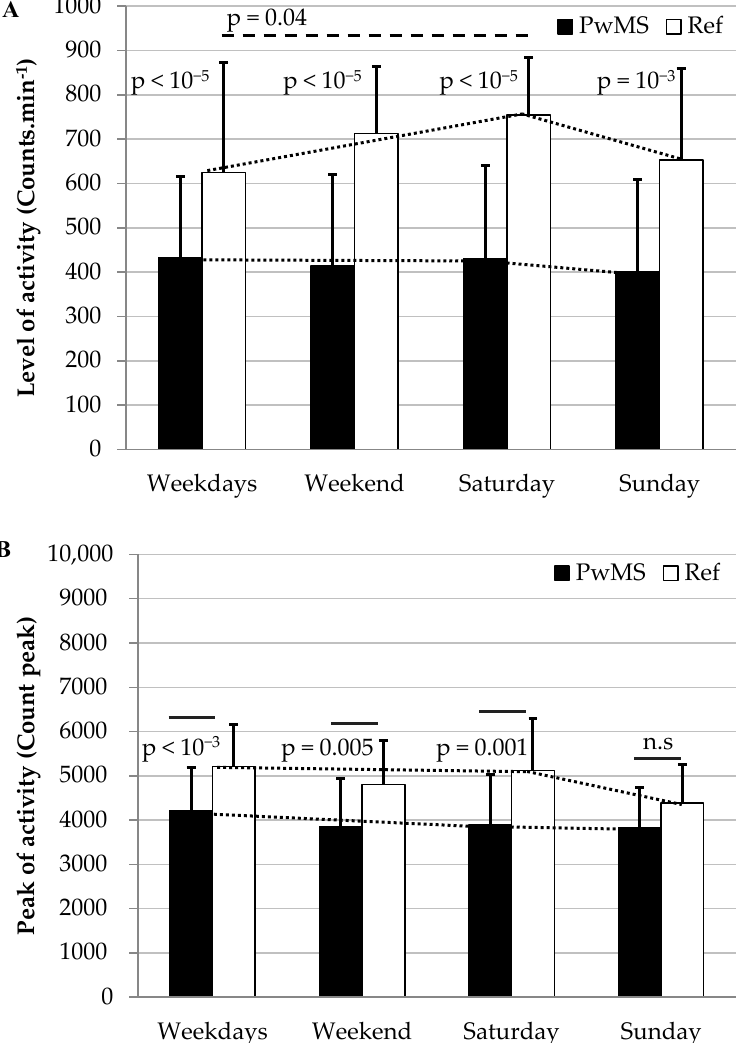
Figure 1. The level of physical activity (mean counts · min − 1 ( A ) and peak ( B )) on the weekdays, weekend, Saturday and Sunday and comparisons between MS and Reference groups. PwMS had a monotone level of activity throughout the week, whereas the Ref group had an improvement of activity on Saturday compared with those on weekdays. Abbreviations: PwMS, Persons with Multiple Sclerosis; Ref, Reference group; n.s, not significant.